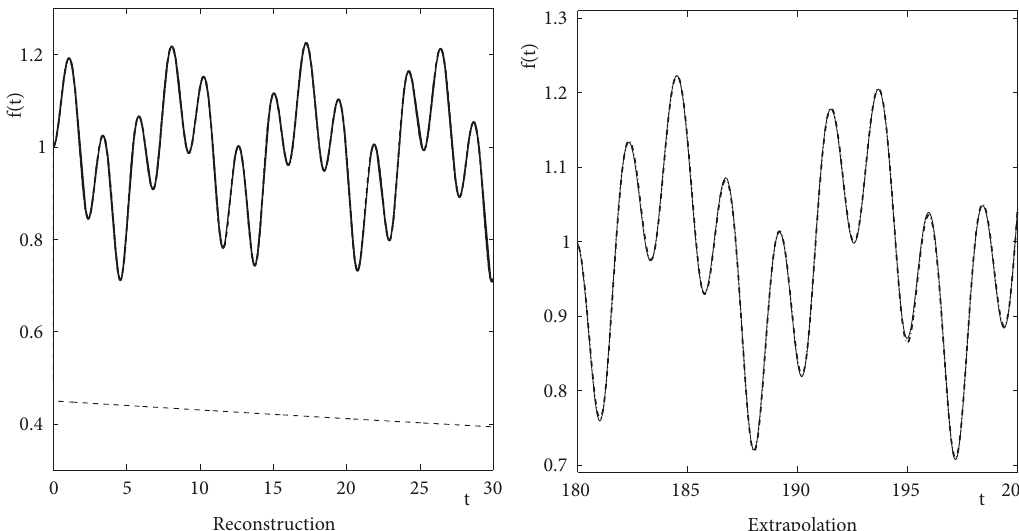
Figure 2: Toy model function defined in (16) (thin solid lines) and the reconstruction using DMD-800 (thick dashed lines) and DMD-1 (thin dashed